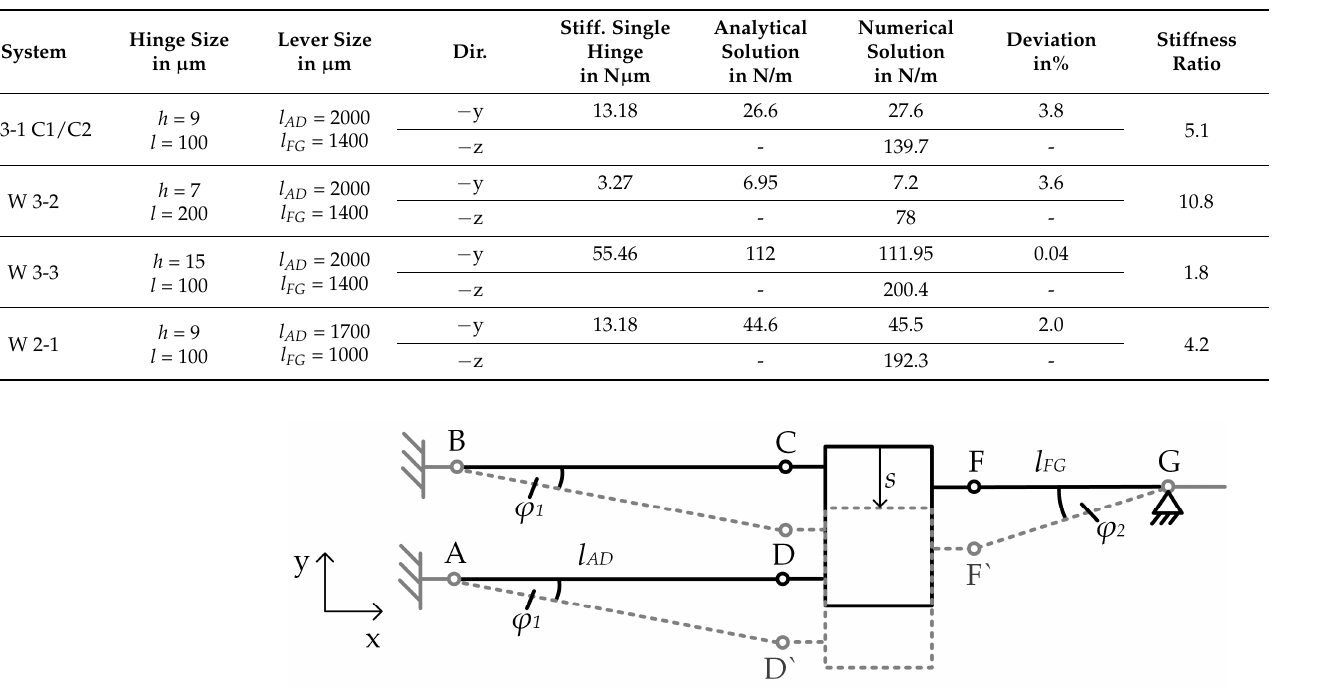
Table 1. Geometrical parameters according to Figures 2 and 3 ( w = 100 µ m) and theoretical stiffness results for a single hinge and for the entire MEMS-based weighing cell systems in direction (dir.) of motion ( − y) and out-of-plane direction ( − z), according to Figure 4a).